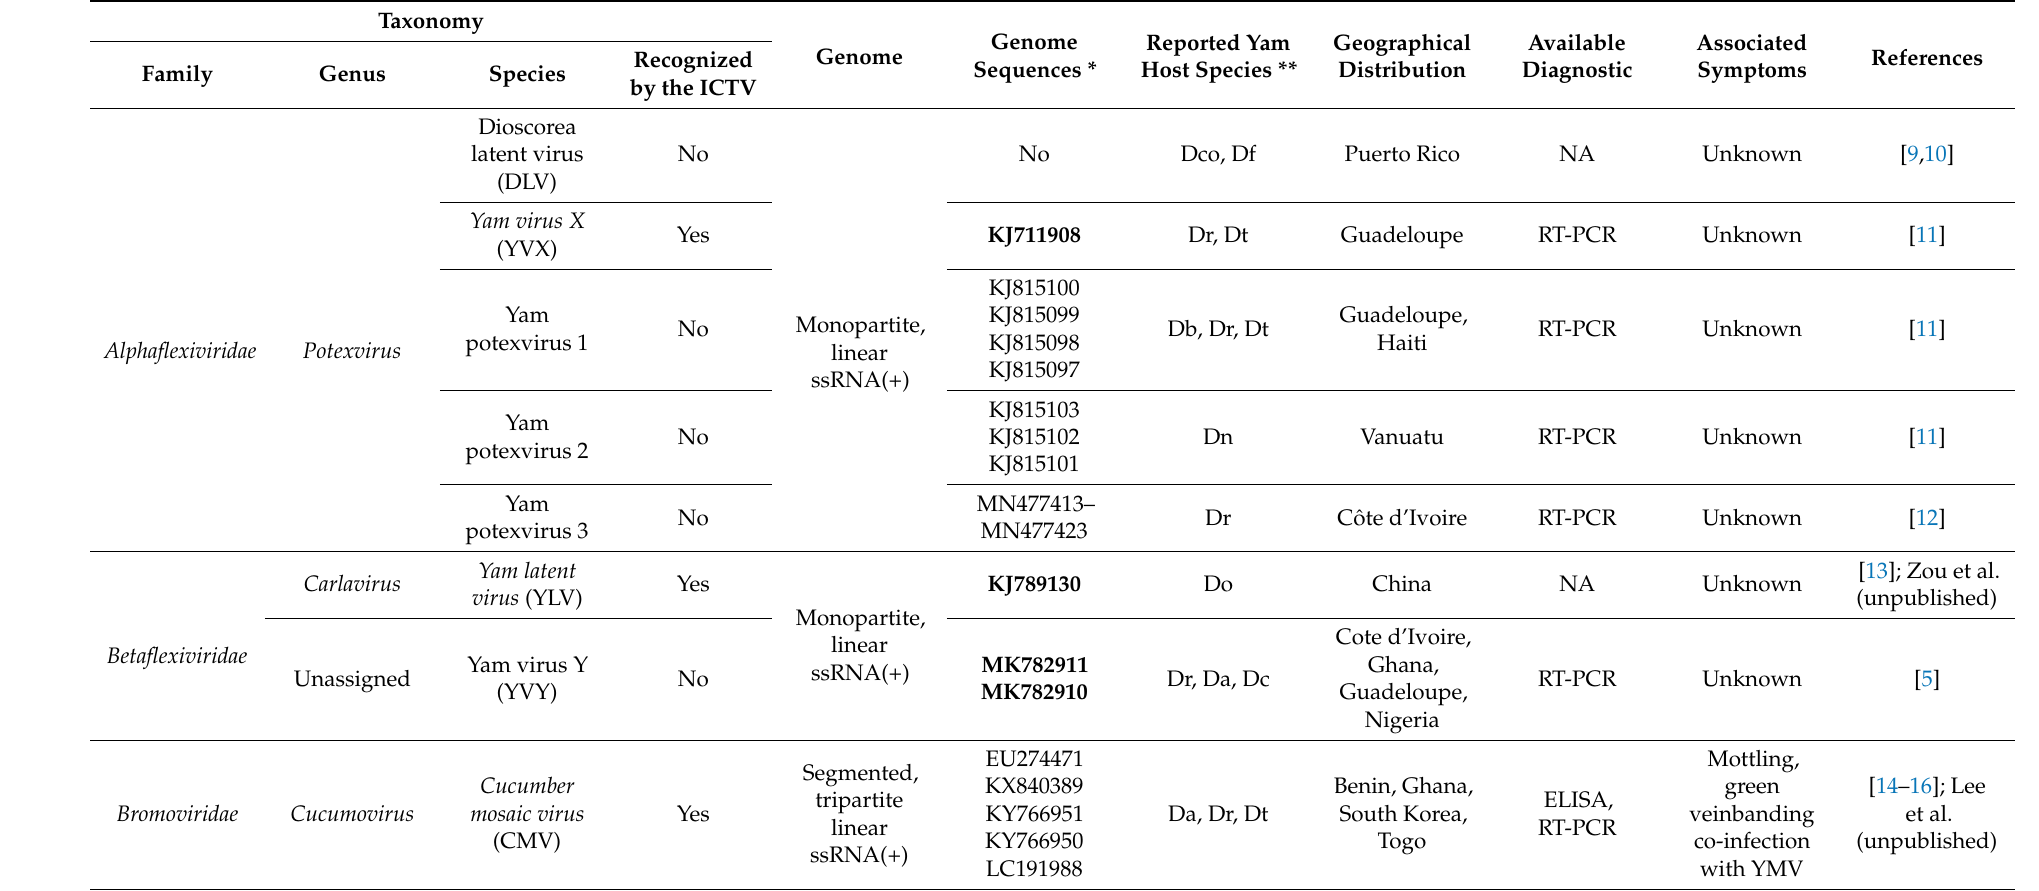
Table 1. Viruses infecting